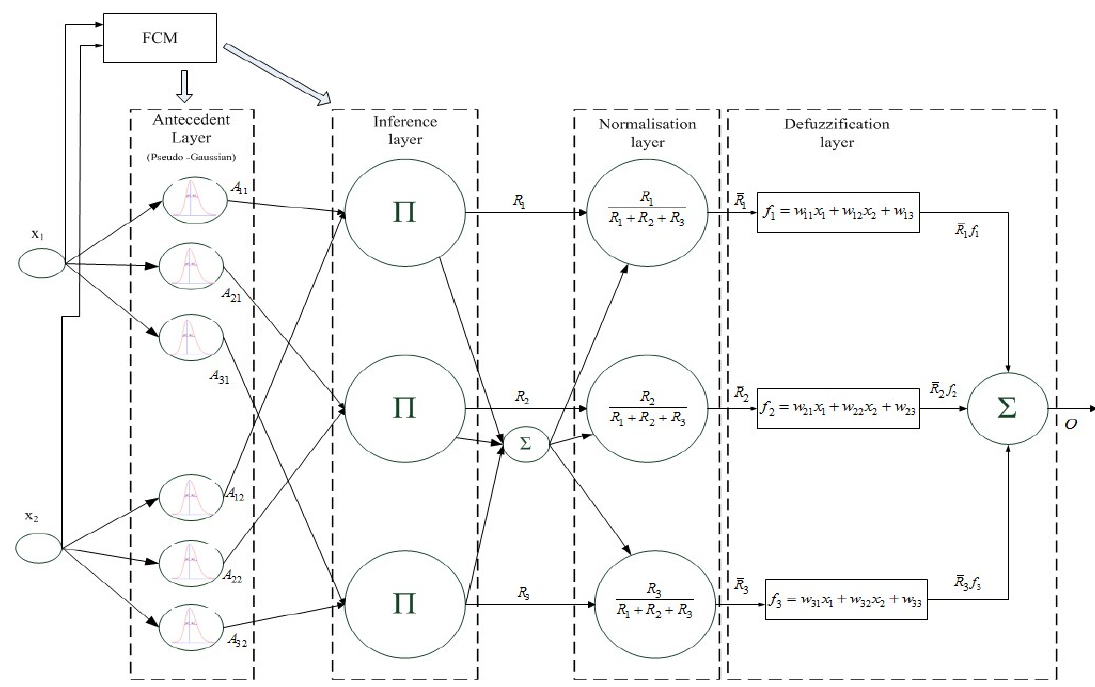
Figure 2. Illustration of AGFINN-TSK system.